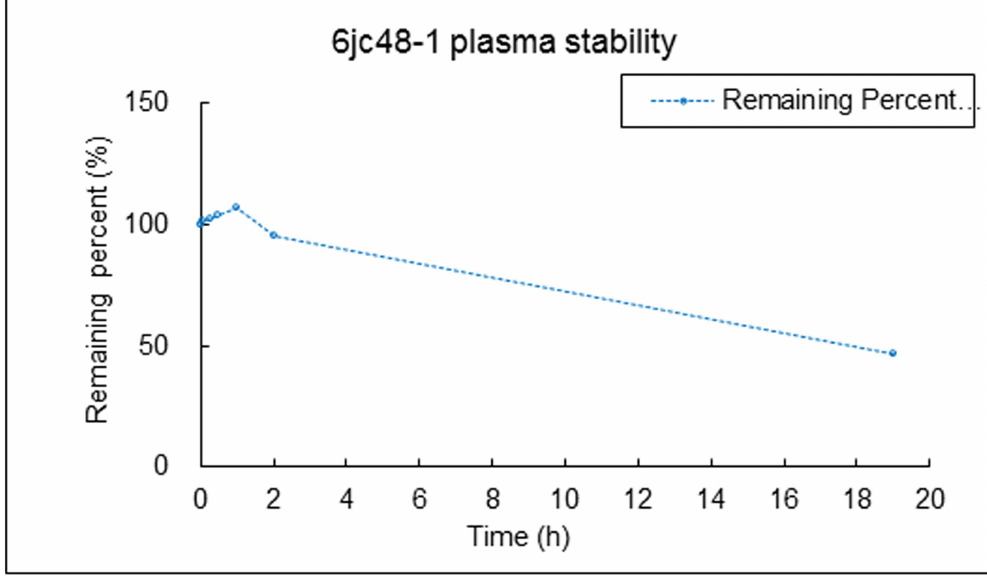
Fig 3. Compound 6jc48-1 plasma stability. Stability was tested by LC/MS/MS after 2 min, 5 min, 15 min, 30 min, 1h, 2h and 19h in the presence of 50% serum. Compound 6jc48-1 was fully stable after 2 hours in serum and after 19h, 46% of compoundremained, indicatingthat plasma stability is